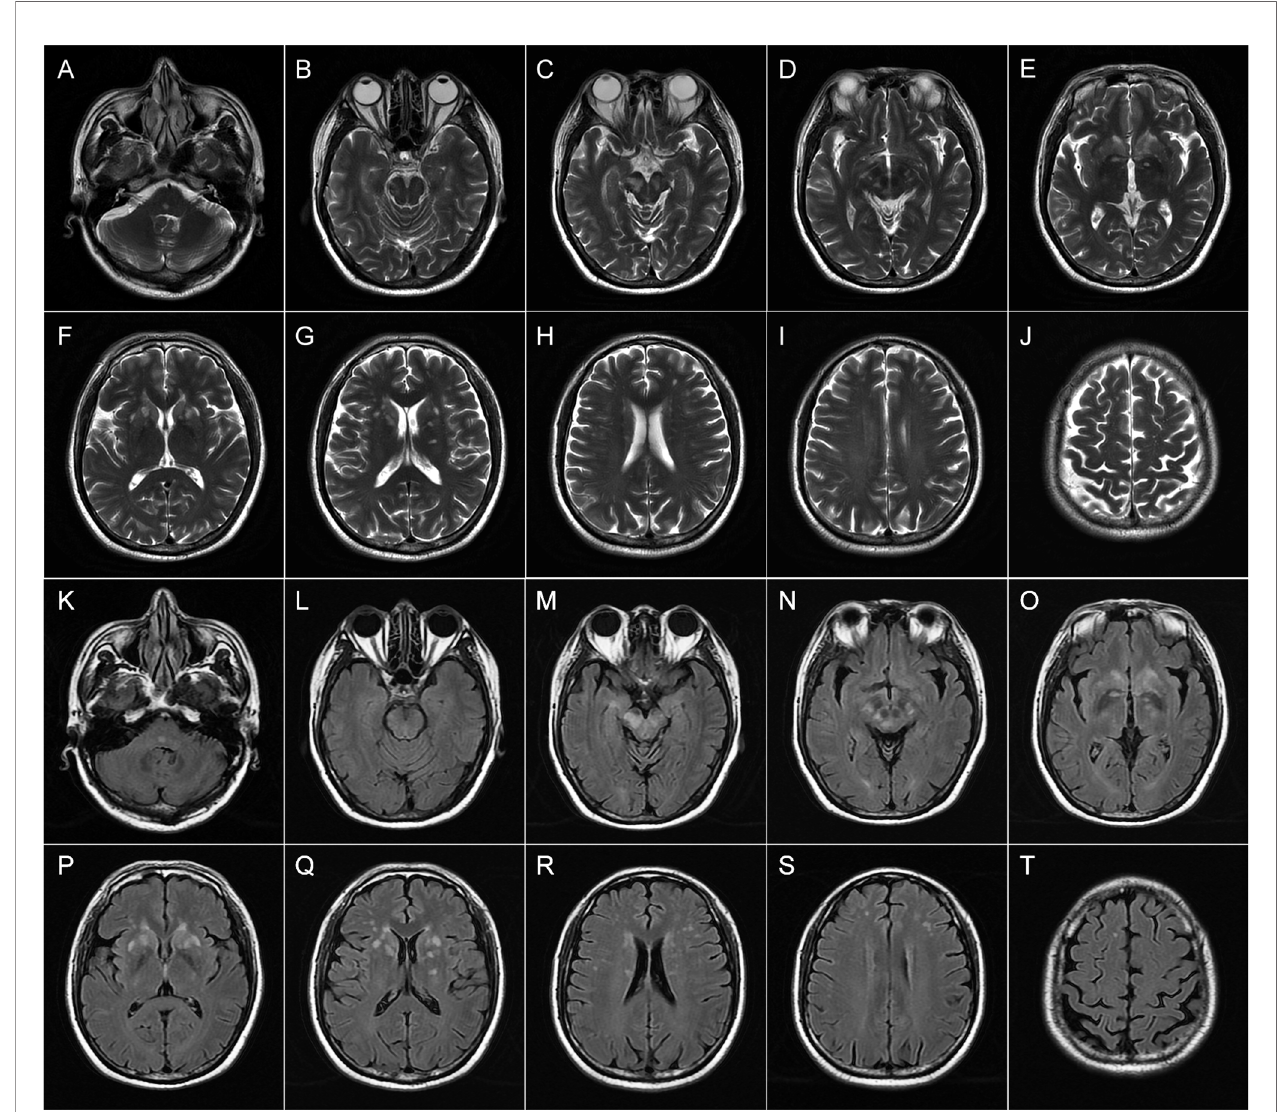
FIGURE 1 | Brain magnetic resonance imaging (MRI) of patient 1 performed during acute attack. Axial T2-weighted (A – J) and FLAIR (K – T) images show multiple patchy hyperintense lesions in the tegmentum of the pons (A, K) , bilateral midbrain (B – D, L – N) , and right hippocampus (C, M) ; ovoid lesions with well-de fi ned borders in the bilateral head of the caudate nucleus and putamen (E – G, O – Q) ; and spotty lesions involving bilateral paraventricular white matters (H, R) and subcortical white matters of the frontal lobes (H – J, R – T)